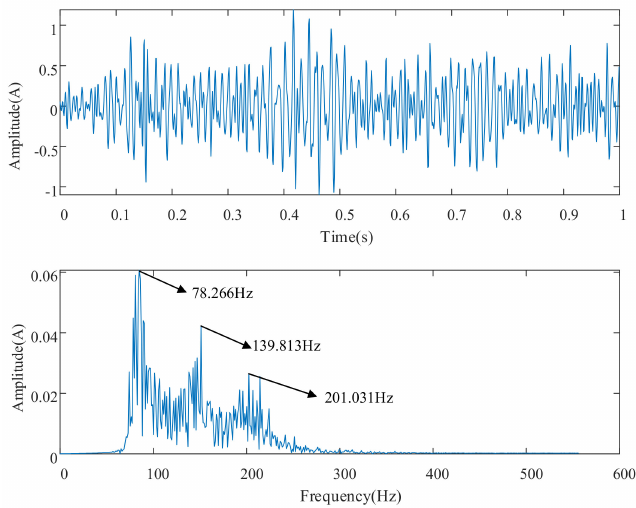
Figure 23. IMF components of compound faults after the second ACSRS − VMD: ( a ) Time − domain; ( b ) frequency domain.